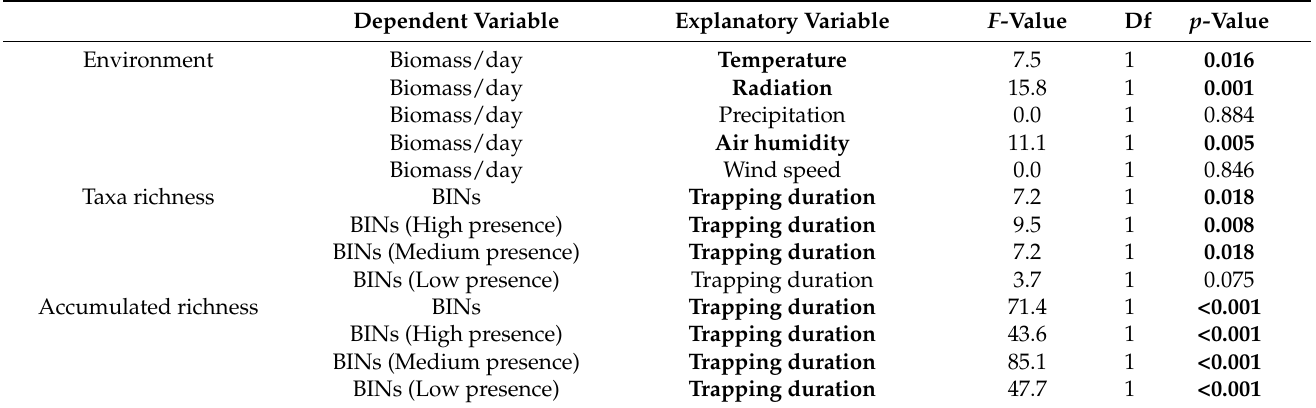
Table 2. Results table of linear regression analyses with type III ANOVA for the effect of the environ- mental variables temperature, radiation, precipitation, air humidity, and wind speed on daily biomass and for the effect of monthly trapping duration on taxa richness and accumulated taxa richness with F -value, degrees of freedom (Df), and p -value. The effects on taxa richness and accumulated taxa richness are also given for subsets of high (taxa caught at 4 sites), medium (taxa caught at 2 or 3 sites), and low presence (taxa caught at 1 site). Bold letters indicate significant